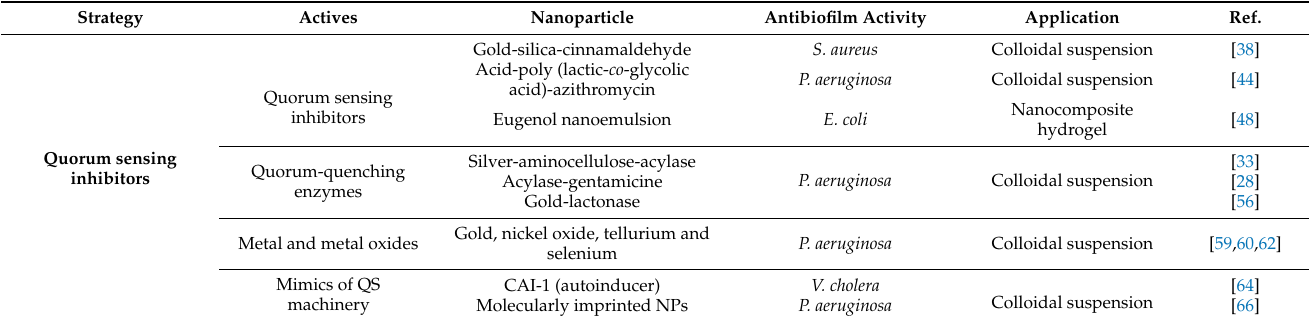
Table 1. Relevant examples of nanomaterials and coatings against